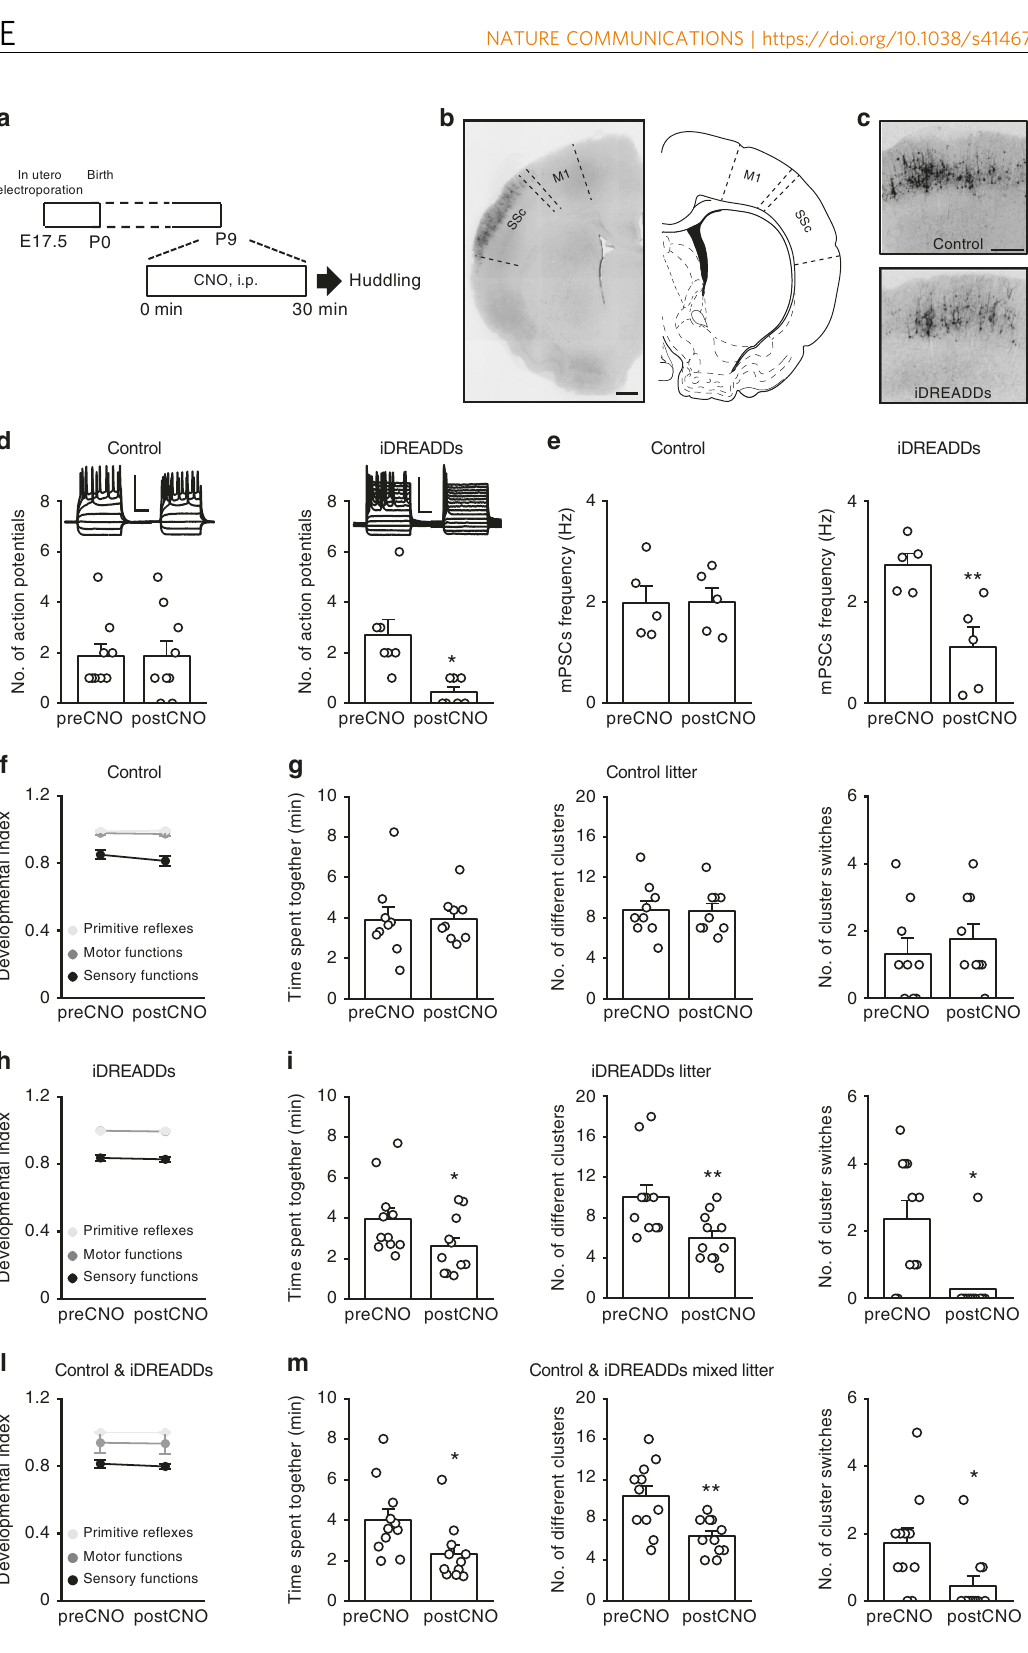
after the CNO injection (10 mg/kg, i.p.; P9; time spent together: Fig. 3l, Supplementary Figs. 3c, 6a). The observation that control pups from control and iDREADDs mixed litters (like iDREADDs-only litters) exhibited a reduction in huddling parameters is consistent with the fact that huddling is a group behavior. Indeed, being part of a litter where some of the littermates have impaired huddling behavior (the